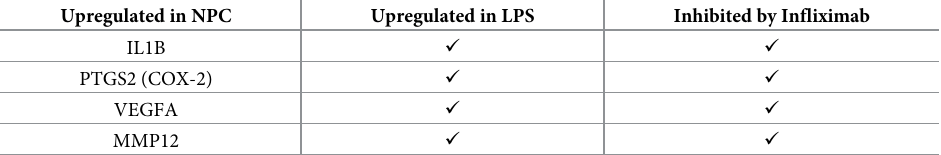
Table 3. IPA analysis table of gene names that are upregulated in LPS-induced damage, NPC tissue, and inhibited by infliximab. Upregulated in NPC Upregulated in LPS Inhibited by Infliximab